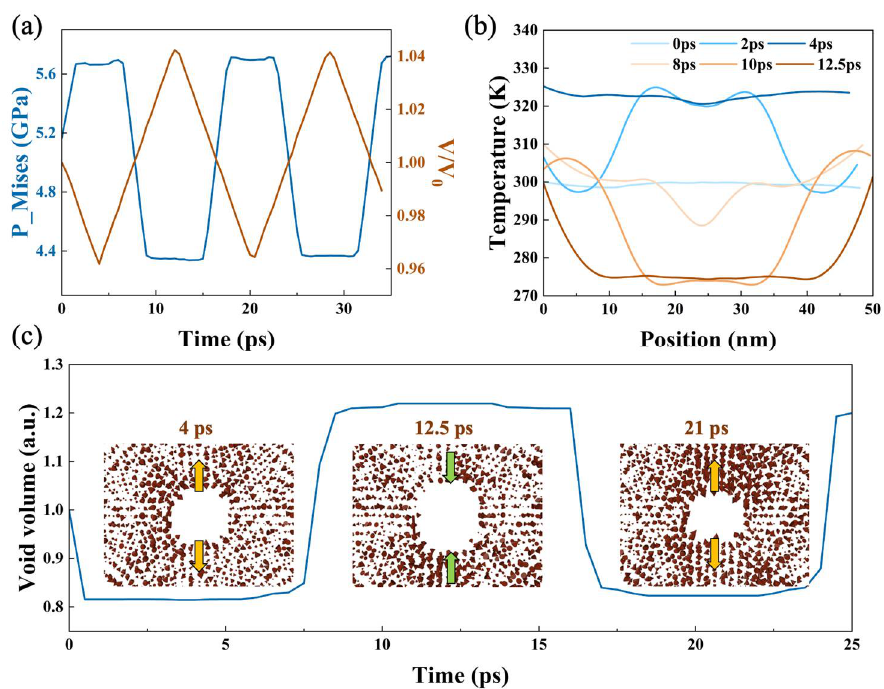
Figure 3. ( a ) Sample volume change and the von Mises stress of the preset void layer, where the blue curve represents von Mises stress and the brown curve represents sample volume. Horizontal axis is along z direction of the sample. ( b ) Evolution of temperature profile at v 0 = 0.25 km/s, and different colors correspond to different evolution times. ( c ) Changes in the preset void volume and microscopic images present atomic displacement vectors.